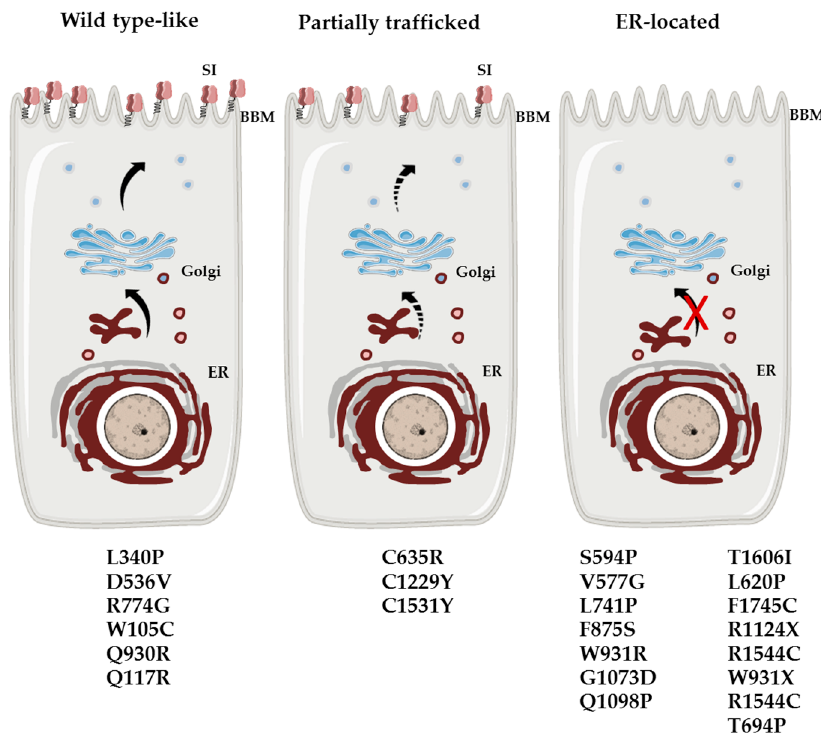
Figure 1. Categorization of the SI mutants into major three biosynthetic protein phenotypes. WT like: the mutants are trafficked along the secretory pathway and mature in a fashion similar to the WT-SI; it is not clear, however, whether an efficient polarized sorting of the mutants to the apical membrane is maintained. Partially trafficked: the mutants are trafficked at a reduced rate between the ER and the Golgi and ultimately to the cell surface. ER block: the mutants are entirely located in the ER. WT: wild type, SI: sucrase-isomaltase, BBM: brush border membrane, ER: endoplasmic reticulum.